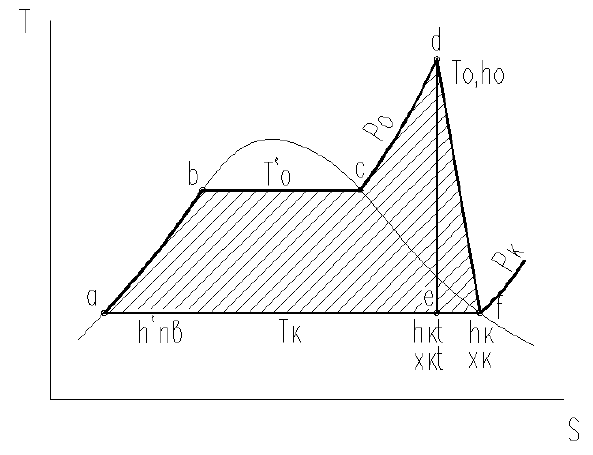
Figure 5. T-S diagram of the thermal cycle of a steam turbine power